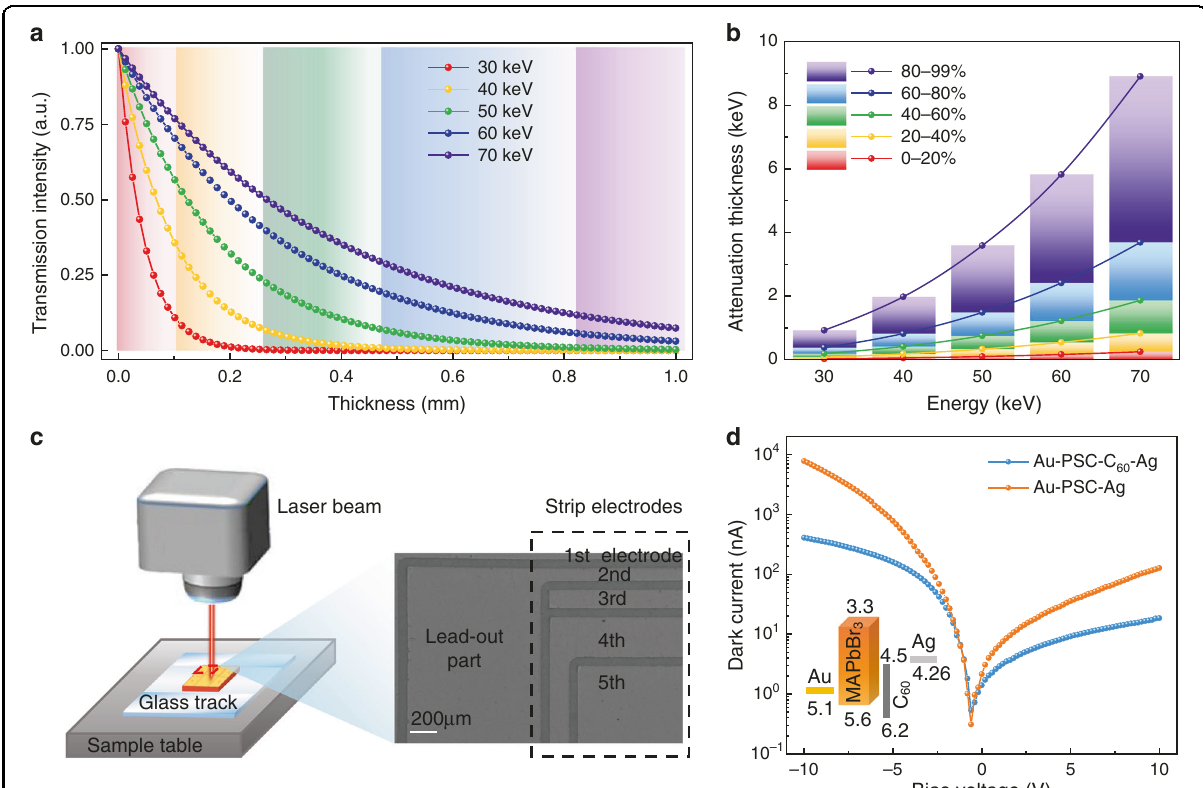
Fig. 2 The design of the electrode structure for the vertical matrix detector. a The thickness-attenuation curve of MAPbBr 3 under different X-ray energy. b The thickness required for every 20% X-ray intensity attenuation under different energy. c Schematic diagram of the strip electrodes etched by laser marking, and the SEM picture of them in the enlarged view. d I – V curves of Au – PSC – Ag device and Au – PSC – C 60 -Ag device in the